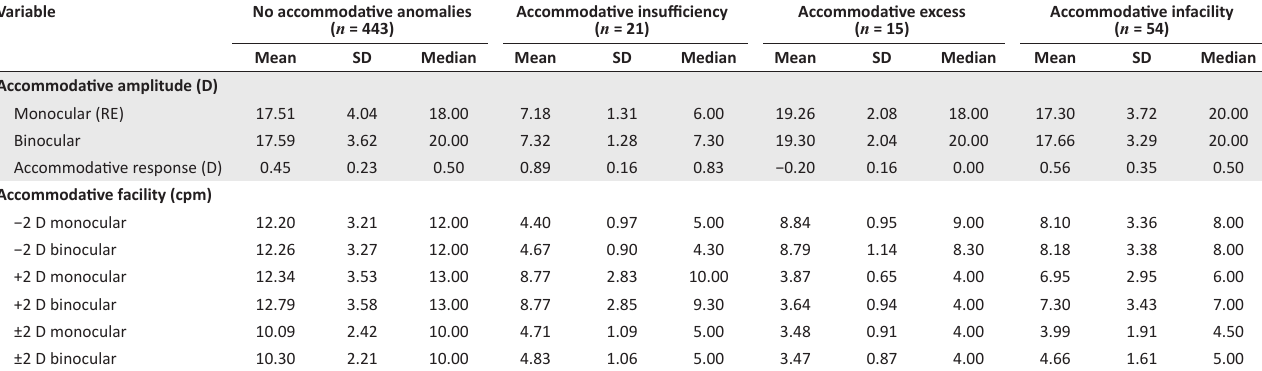
FIGURE 2: Distribution of specific accommodative anomalies by (a) age group, (b) gender and (c) school TABLE 5: Accommodative findings for various accommodative groups.